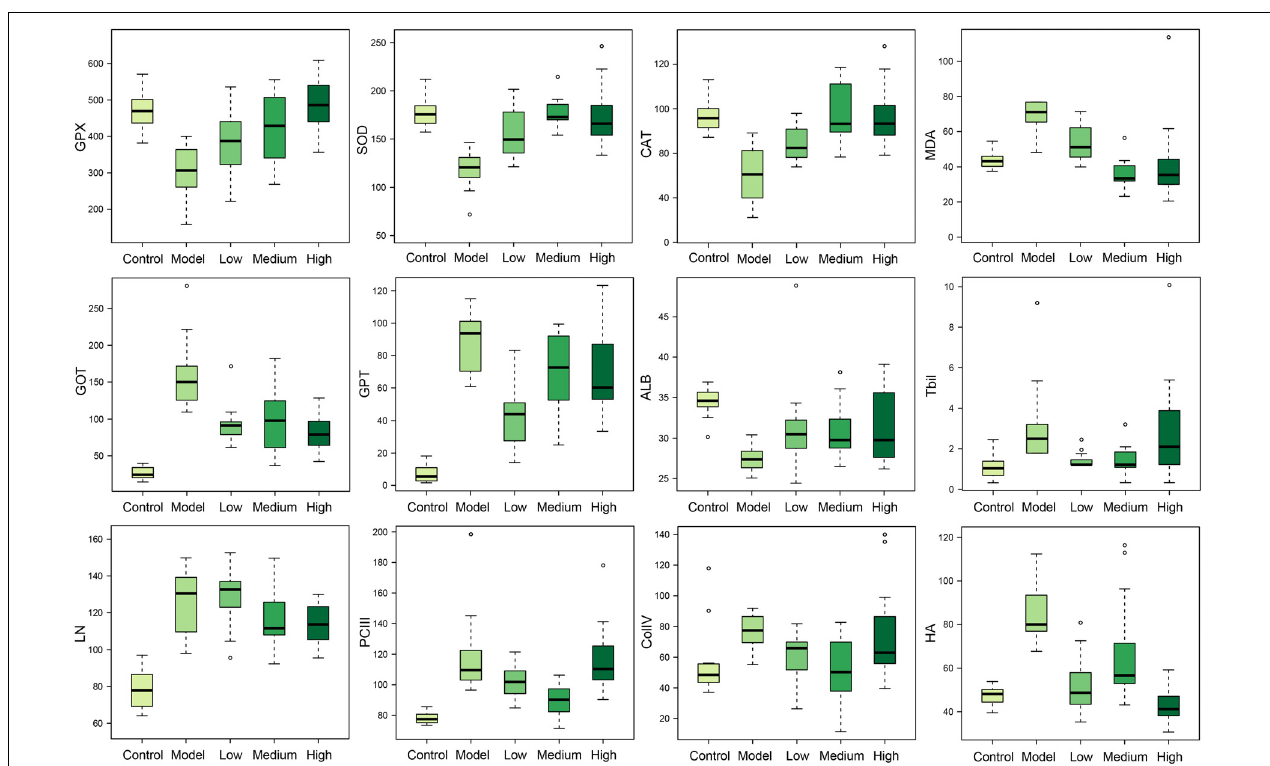
FIGURE 2 | Boxplots of serum markers of oxidation stress (GPX, SOD, CAT, and MDA), liver function (GOT, GPT, ALB, and TBil), and hepatic fibrosis (LN, PCIII, ColIV, and HA) for rats form control, model, and low, medium, and high dose of SWGNP treated groups. The boxes cover 25% quartile and 75% quartile of the data. The line in the box represents the median value. The extended whiskers show the extent of the rest of the data, and outliers are shown as open